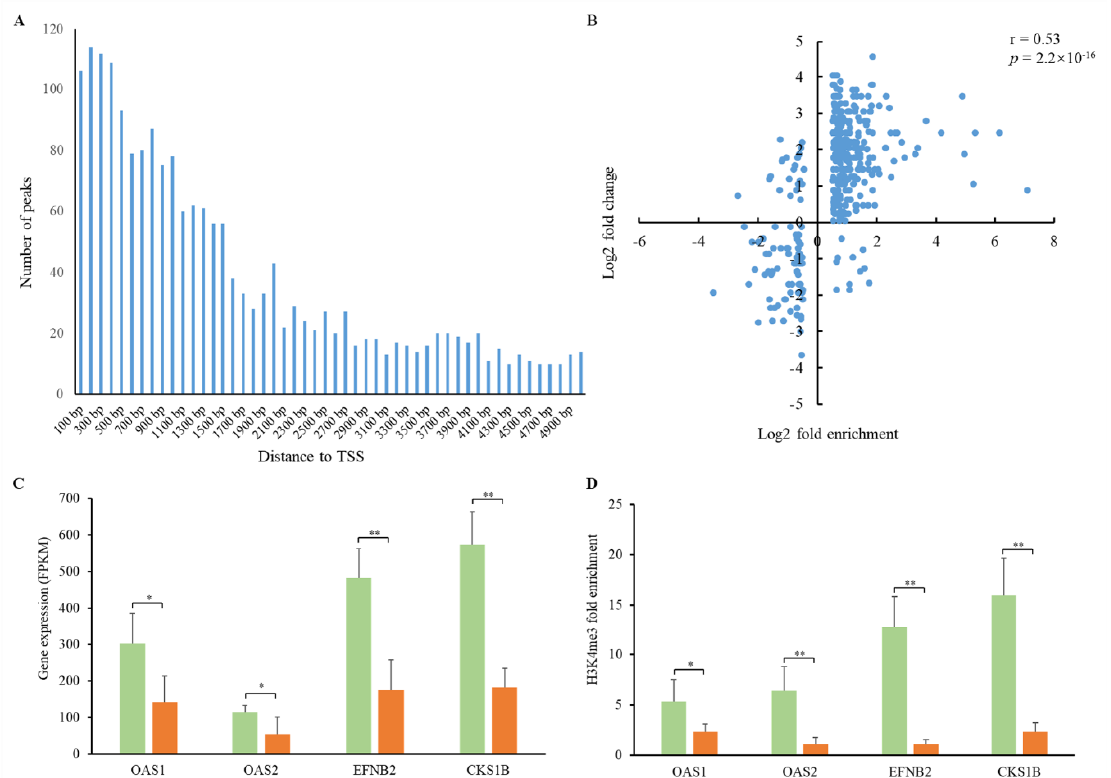
Figure 5. H3K4me3 peak distribution and associations with gene expression. ( A ) Distribution of H3K4me3 peaks with the distance to the transcription start site (TTS). ( B ) Associations between H3K4me3 enrichment and gene expression. Pearson’s coefficient r = 0.53, p = 2.2 × 10 −16 . ( C ) Expression of the OAS1 , OAS2 , EFNB2 , and CKS1B genes in PEDV-infected and control samples. ( D ) H3K4me3 fold enrichment of the OAS1 , OAS2 , EFNB2 , and CKS1B genes in PEDV-infected and control samples. Green and oranges bars represent PEDV-infected and control samples, respectively. * p < 0.05, ** p < 0.01.